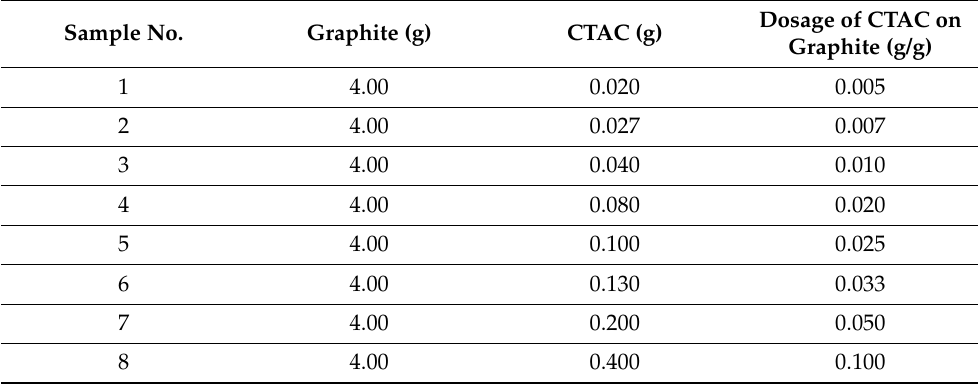
Table 2. Graphite sedimentation experiment. Sample